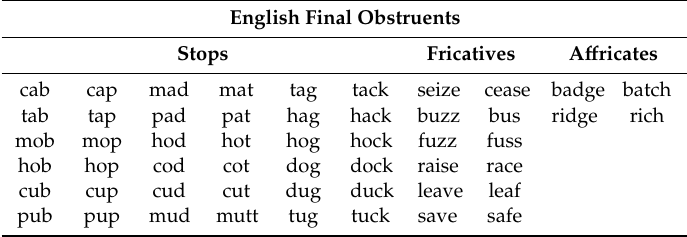
Table A2. English minimal pairs with voiced and voiceless obstruents in word-final